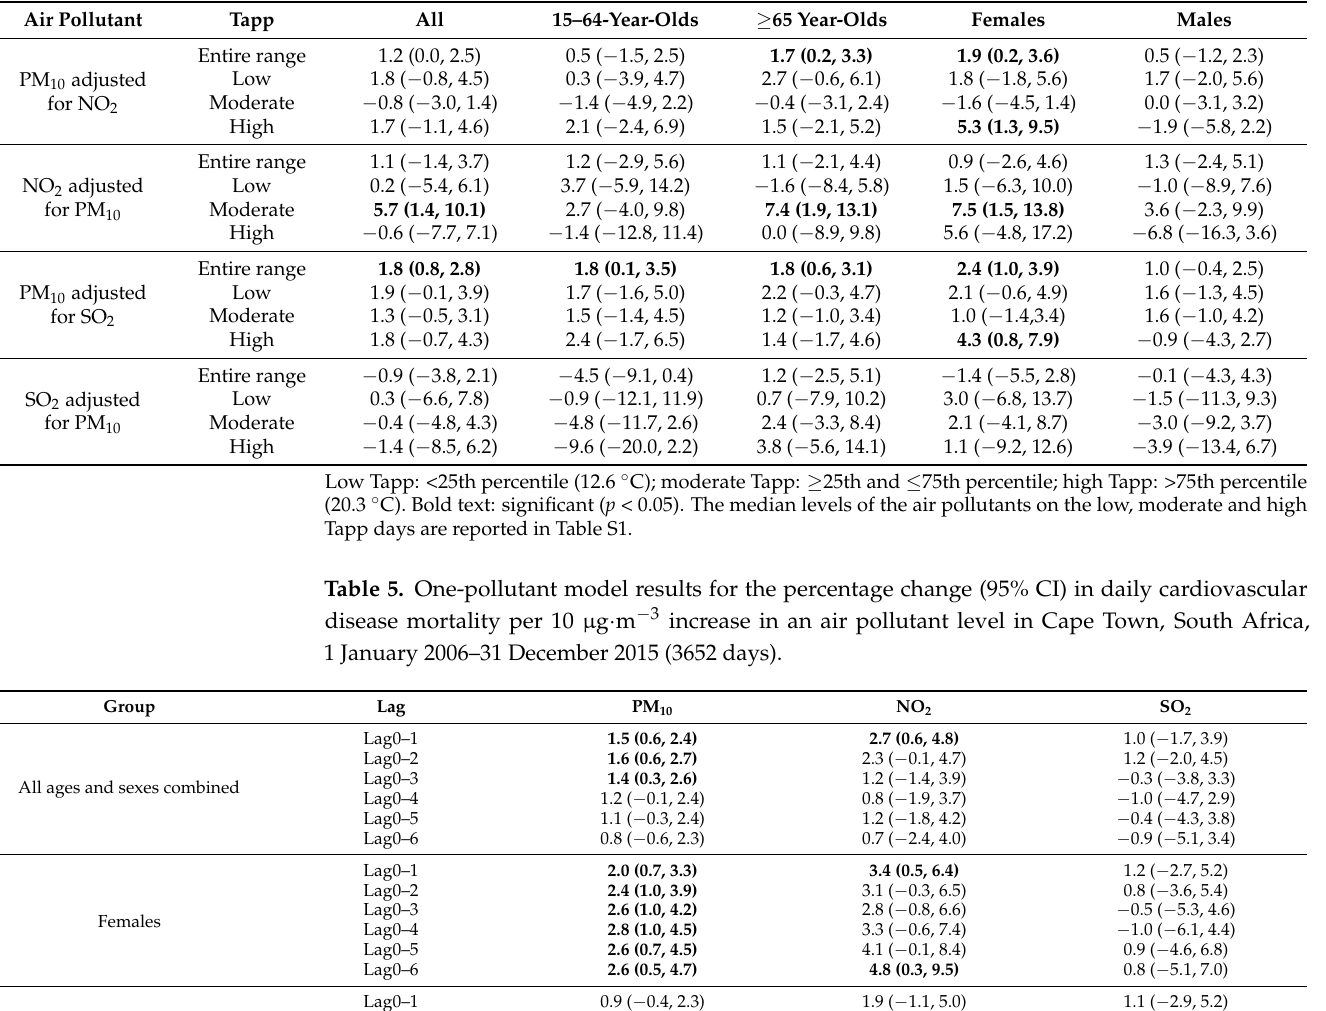
Table 4. Two-pollutant model results for the percentage change (95% CI) in daily cardiovascular